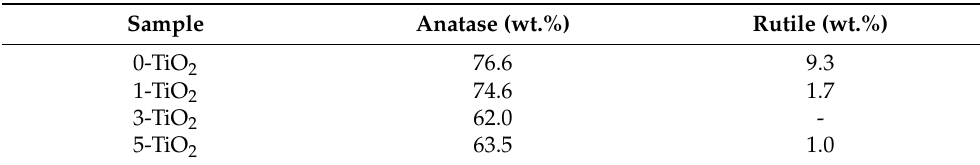
Table 4. The anatase and rutile phases’ mass fraction of the PEO coatings without and with different concentrations of anatase TiO 2 nanoparticles.